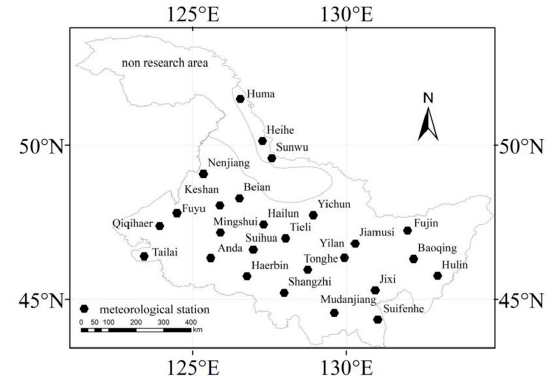
Figure 1. Study area and distribution of meteorological stations in Heilongjiang